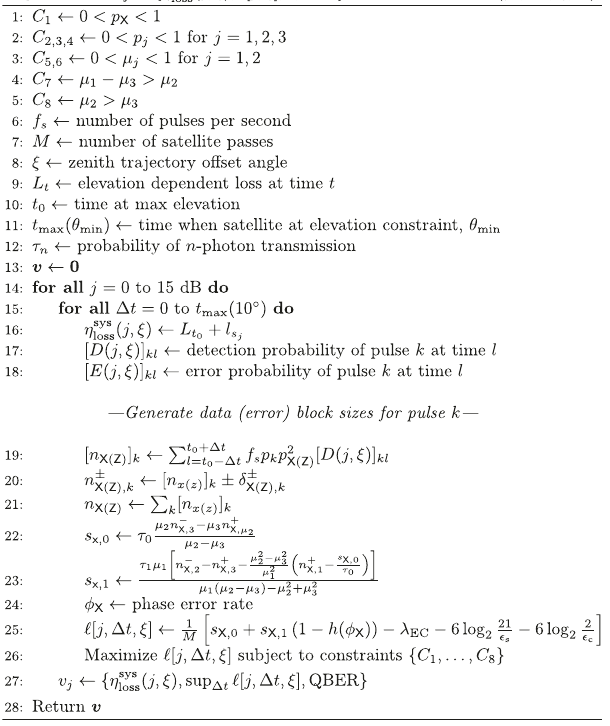
Fig. 8 Pseudocode for the optimised fi nite key length. We consider a pulse repetition rate f s , M satellite passes in the plane offset by angle ξ from the zenith plane, and time dependent losses L . An elevation constraint of θ min ¼ 10 (cid:2) imposes realistic local constraints of establishing an optical link between the OGS and satellite. The key length is optimised over all protocol parameters and a transmission time window Δ t over which the raw key is for bases X(Z) and the acquired. The correction terms δ ± X ð Z Þ ; k intensities μ k are determined from the multiplicative Chernoff bound that account for fi nite statistics 36